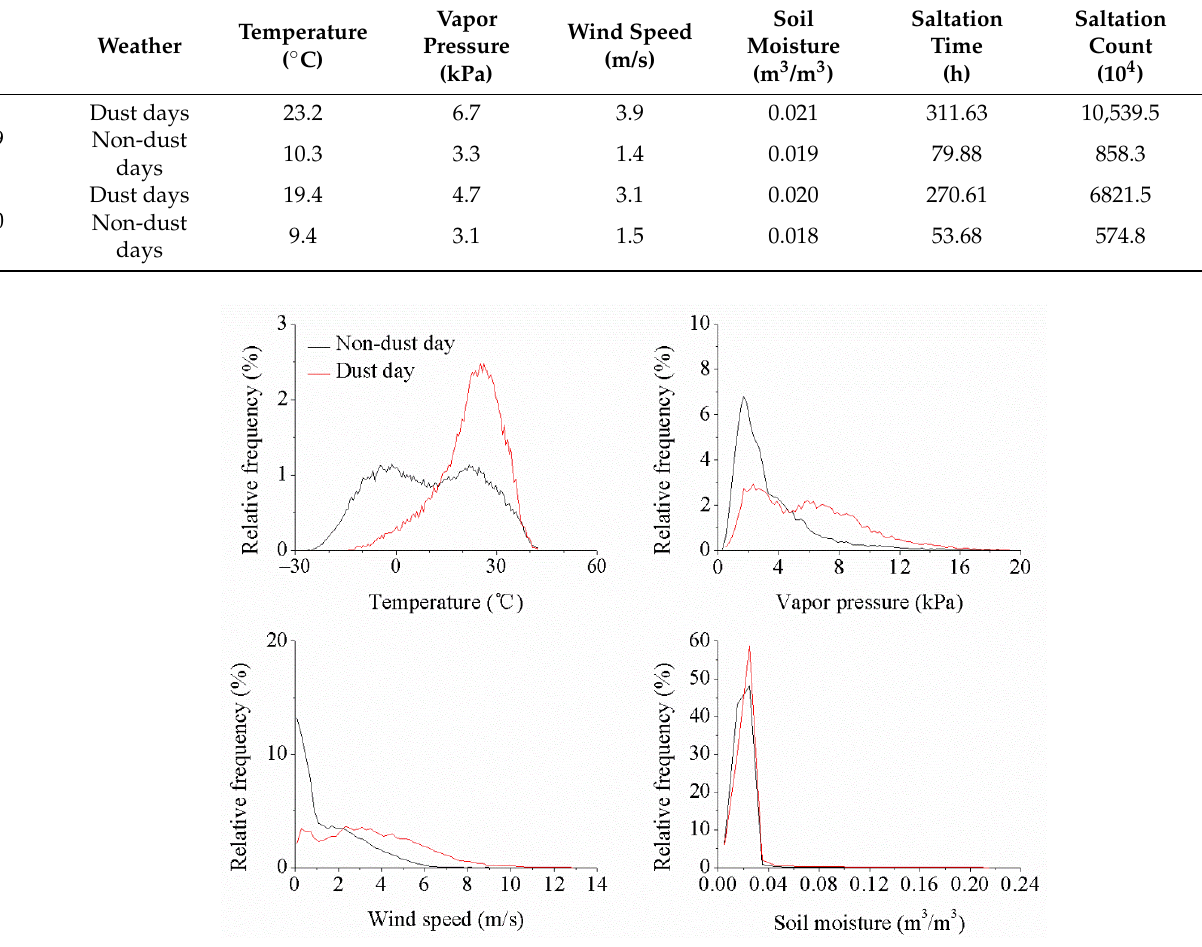
Figure 4. Relative distributions of temperature, wind speed, vapor pressure, and soil moisture on dust and non-dust